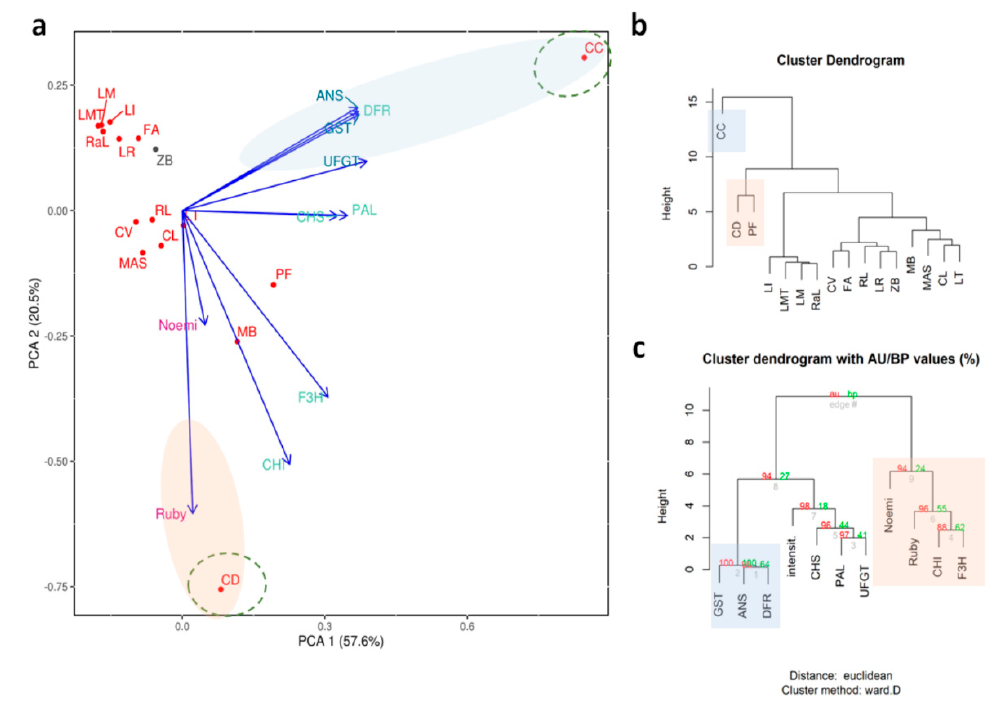
Figure 5. Statistical analyses carried out on accessions selected for their petal pigmentation. ( a ) Principal components analysis; cluster dendrograms based on the distributions of expressions focused on ( b ) accessions and on ( c ) genes where AU refers to Approximately Unbiased p -value and BP is for Bootstrap Probability value. Each accession is indicated by code: ‘Lima rossa corrugata’—